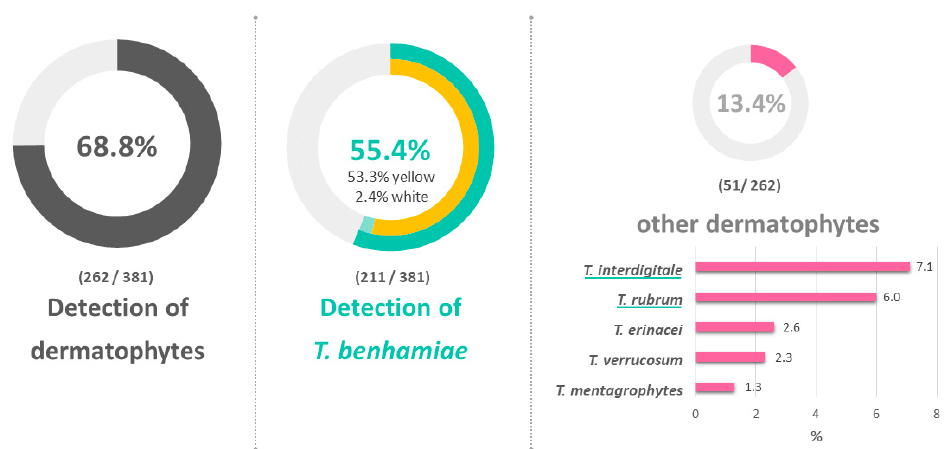
Figure 2. Detected dermatophytes on breeding guinea pigs.